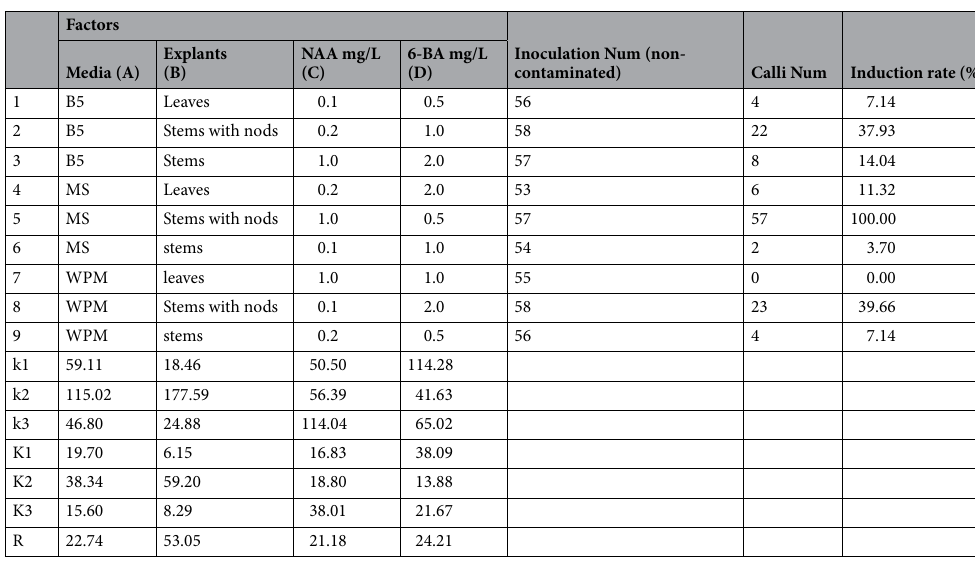
Table 1. Orthogonal experiment (L 9 (3 4 )) analyzing the effects of different factors on callus induction of P . grandiflorus